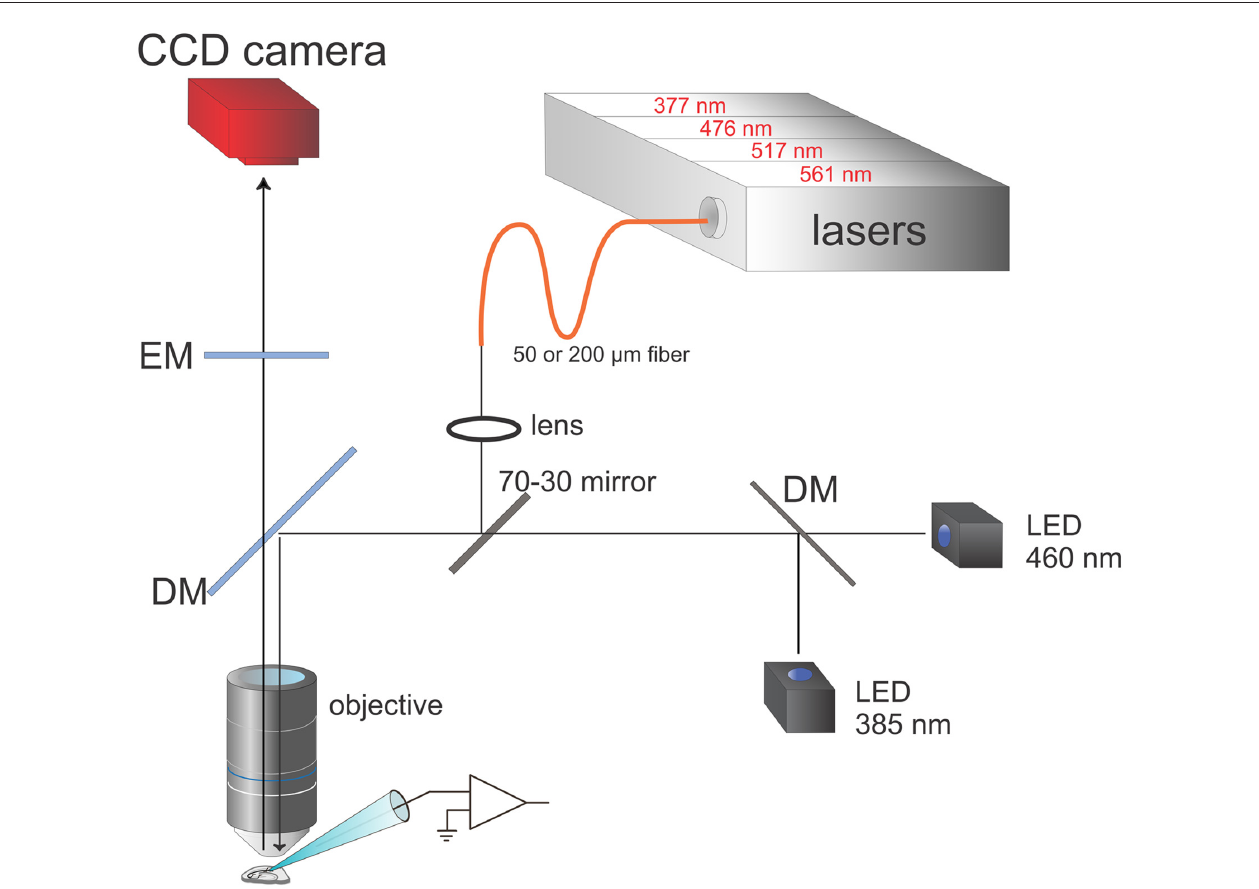
FIGURE 3 | Schematic of modified apparatus including both LEDs and lasers. The box at the top contains four lasers at the indicated wavelengths. The laser outputs, which can be separately controlled, are combined and focused onto either a 50 µ m or 200 µ m diameter fiber optic. The face of the fiber is focused with a lens and the objective onto a region of the slice, after 30% of the light is reflected off a mirror in the microscope body and a special DM in a standard filter cube (see Figure 1B for a typical filter set). The LED outputs are combined and 70% of the light passes through to preparation. Software selects combinations of LEDs and lasers to excite the indicator dyes in the cell of interest. The CCD camera (RedShirtImaging, NeuroCCD-SMQ) detects the fluorescence changes with frames synchronized with the laser or LED